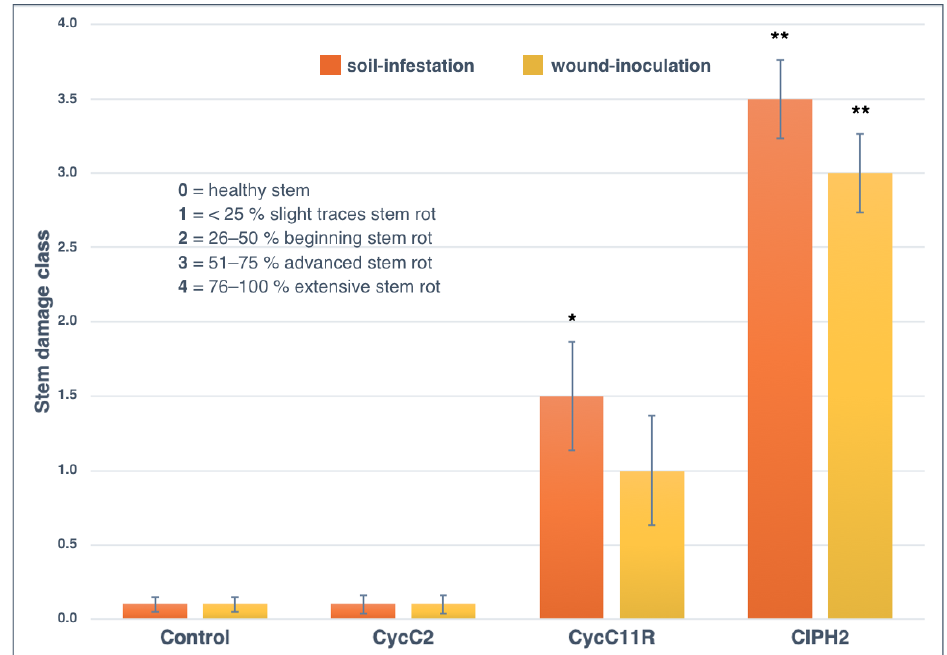
Figure 7. The mean stem damage class of Cycas revoluta plants two months after transplanting in the soil-infestation and wound-inoculation tests with non-infested soil/non-inoculated control (control), P. multivora (CycC2), P. nicotianae (CycC11R) and P. pseudocryptogea (CIPH2). Bars show standard deviations; asterisks represent statistical significances (** = p < 0.01; * = p < 0.05).